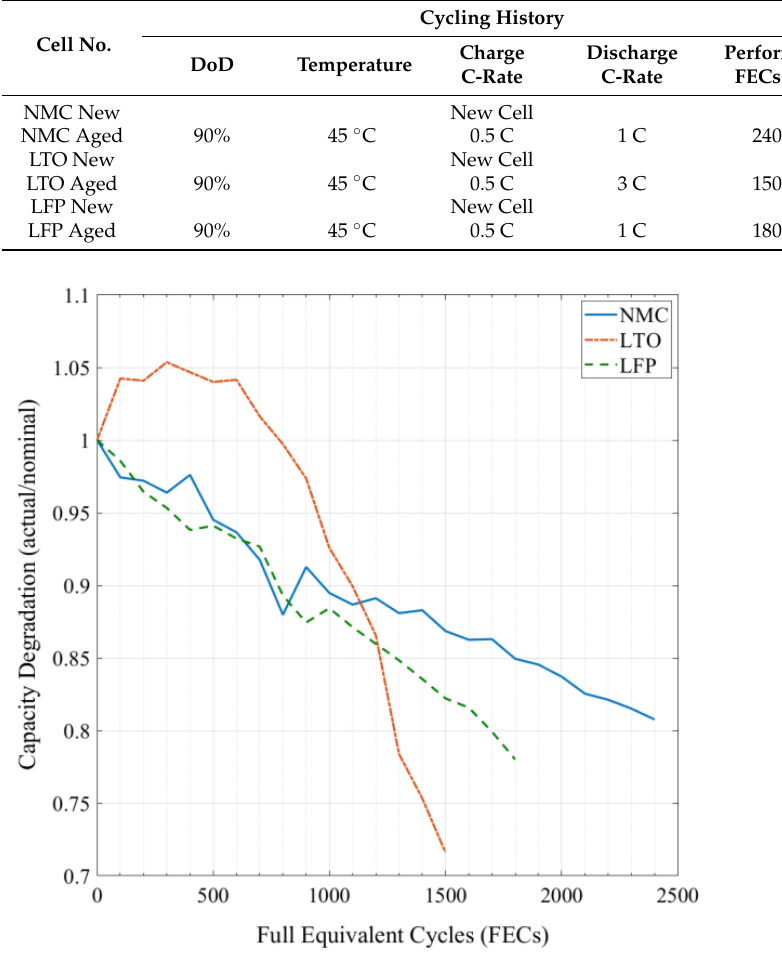
Figure 3. Capacity degradation of aged cells under similar test conditions.